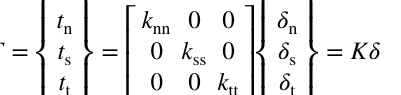
Fig. 7 Relationship between the Q value and the debonding length of rockbolt under different pull-out loads